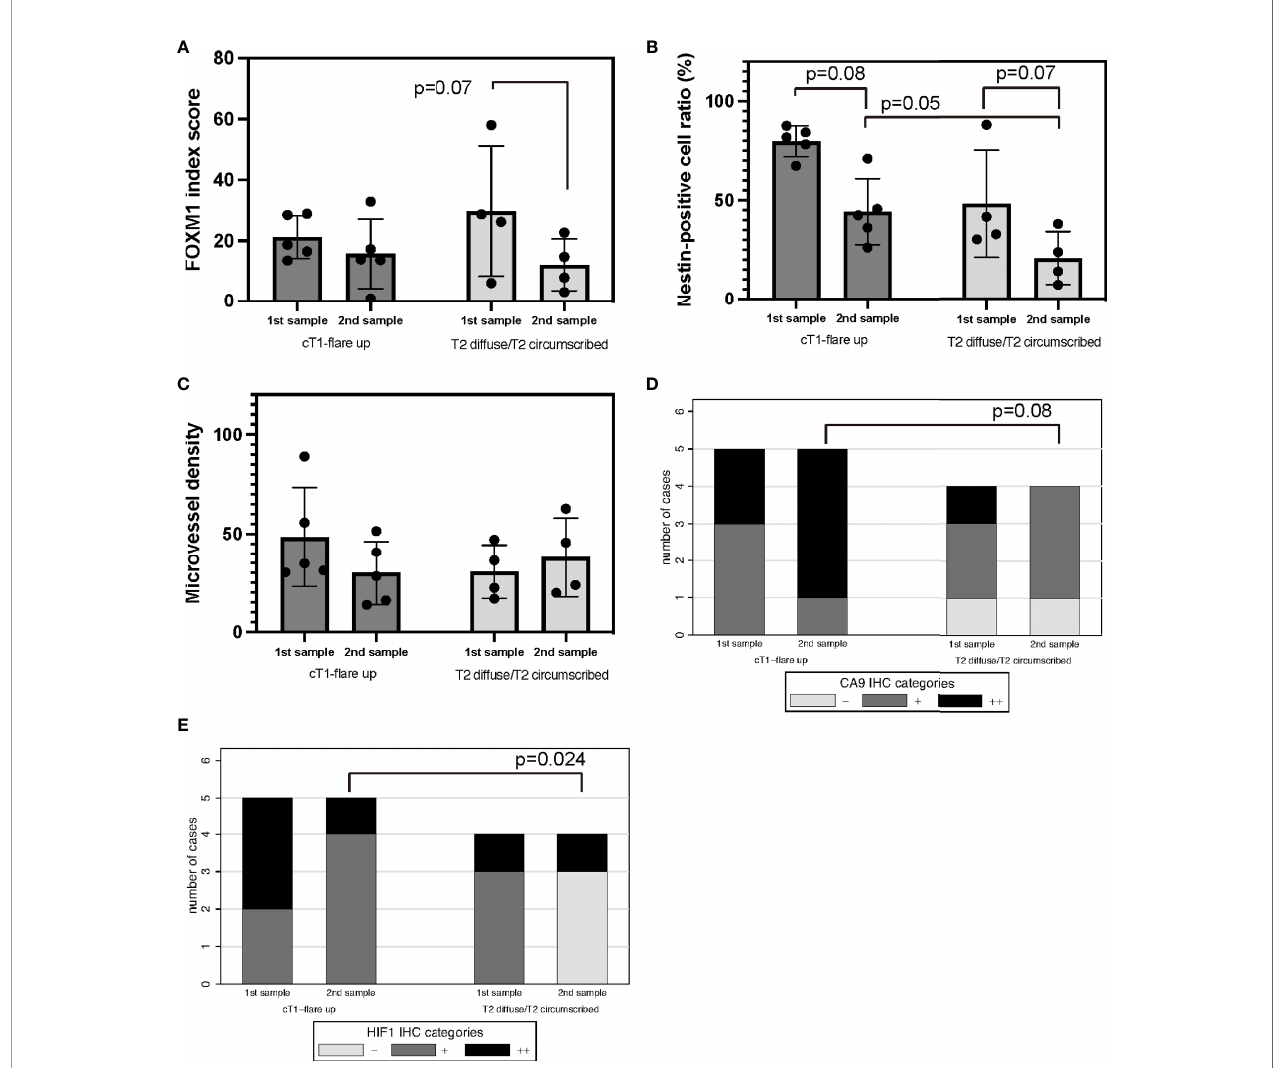
FIGURE 6 | Recurrence pattern on MRI after Bev therapy; “ cT1 fl are-up ” vs. “ T2-diffuse/T2-circumscribed ” in tumor oxygenation, stemness, and immunological TME. Recurrent GBM after Bev therapy in cT1 fl are-up and T2-diffuse GBM. FOXM1 (A) , nestin (B) , MVD (C) , CA9 (D) , and HIF-1 a expression (E) . Error bar; standard deviation. Bev, bevacizumab; CA9, carbonic anhydrase 9; FOXM1, Forkhead box M1; GBM, glioblastoma; HIF-1 a , hypoxia inducible factor-1 alpha; MRI, magnetic resonance imaging; MVD, microvessel density; TME, tumor